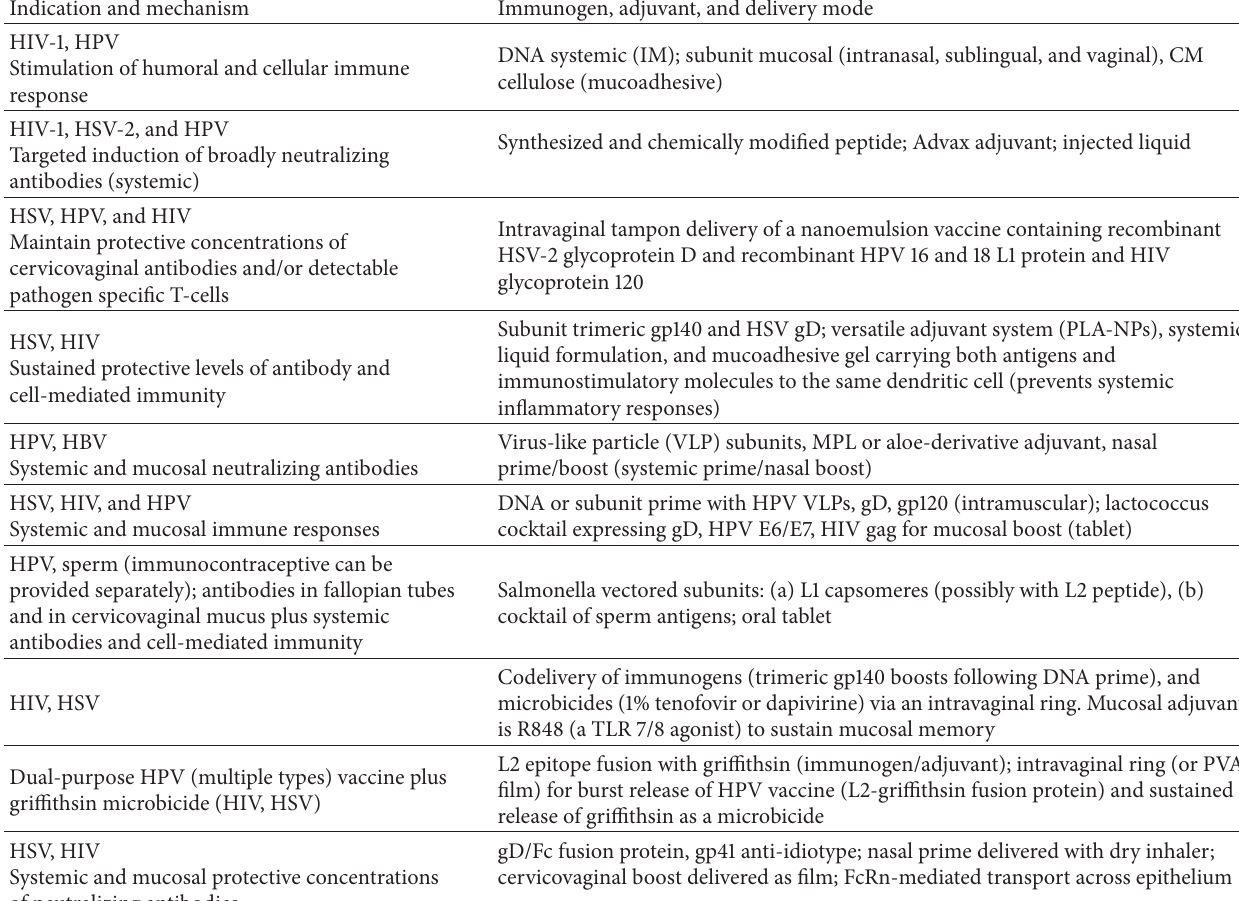
Table 3: Multipurpose RH Vaccine Working Group: active immunization